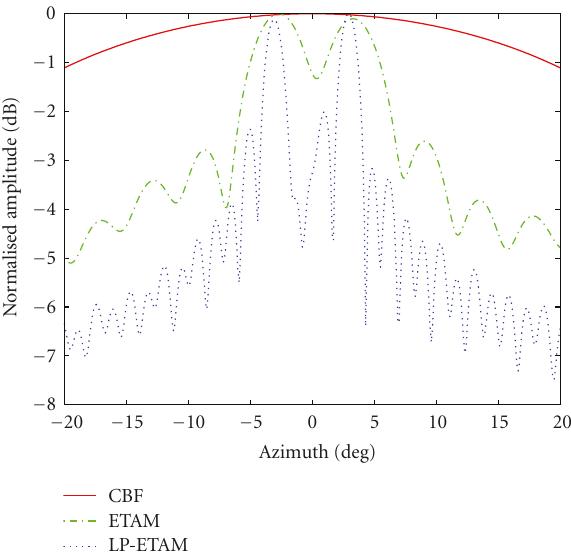
Figure 4: The comparison of spatial spectrums of the three methods for two widely spaced sources.